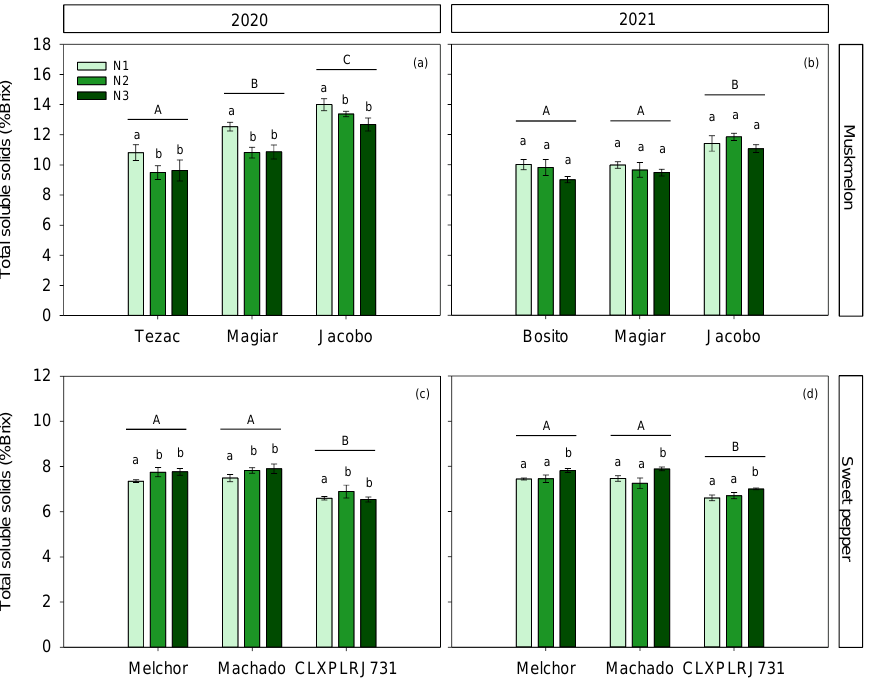
Figure 3. Fruit total soluble solids (TSS), expressed in %Brix, for three cultivars and three N treatments, for muskmelon ( a , b ) and sweet pepper ( c , d ) crops, conducted in 2020 and 2021 years. Different lowercase letters show significant differences between N treatments within each cultivar; different uppercase letters show significant differences between cultivars. Values are means ± SE.